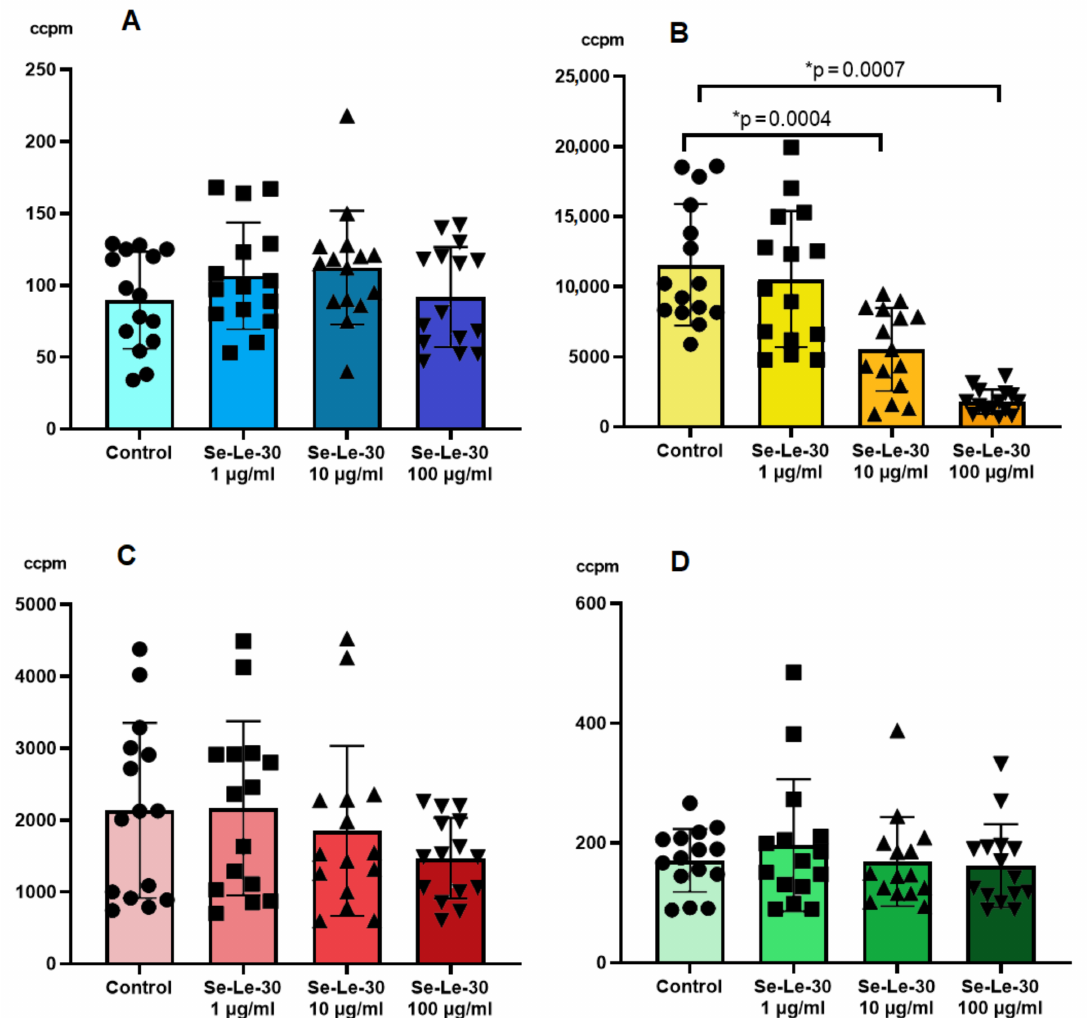
Figure 1. The effect of Se-Le-30 (in the concentrations of 1, 10 and 100 µ g/mL) on the proliferation of human peripheral blood mononuclear cells (PBMCs) non-stimulated ( A ), stimulated with anti-CD3 monoclonal antibody (OKT3, B ), phyto- hemagglutinin (PHA, C ) or suspension of Staphylococcus aureus Cowan strain (SAC, D ). The proliferation of lymphocytes was examined on the DNA synthesis level by the measurements of 3H-thymidine incorporation. The results are presented as a level of radioactivity measured as ‘corrected counts per minute’ (ccpm). Statistical differences were considered when p < 0.05. The mean value ( n = 15) and standard deviation are given. * p < 0.05 vs.